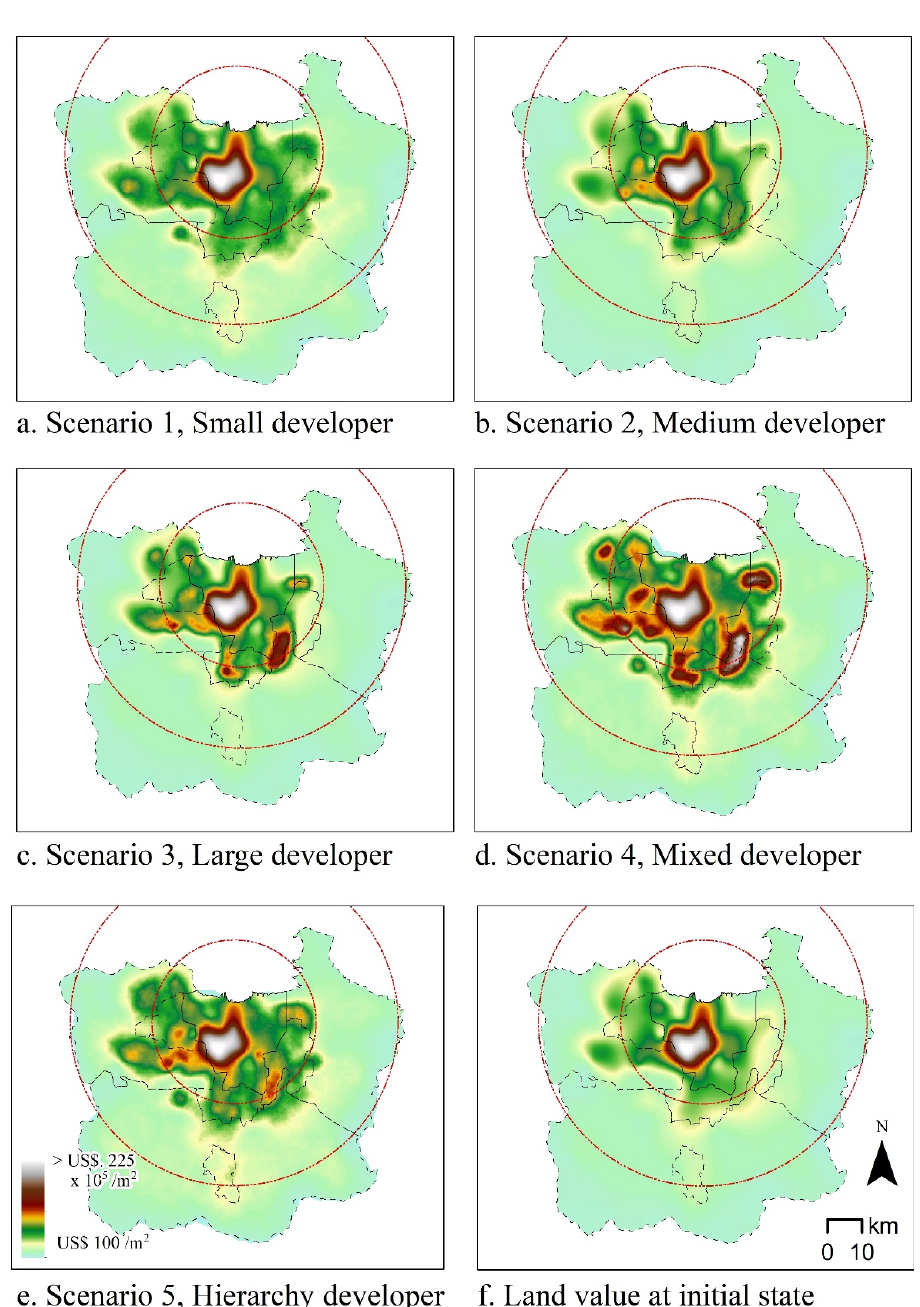
Figure 6. The increase in average land values at t = 216 months (or 18 years) in new urban areas, generated from 100 simulations of the ABM under each scenario. The first and second radial lines represent 25 km and 50 km distance to Jakarta’s CBD, respectively.